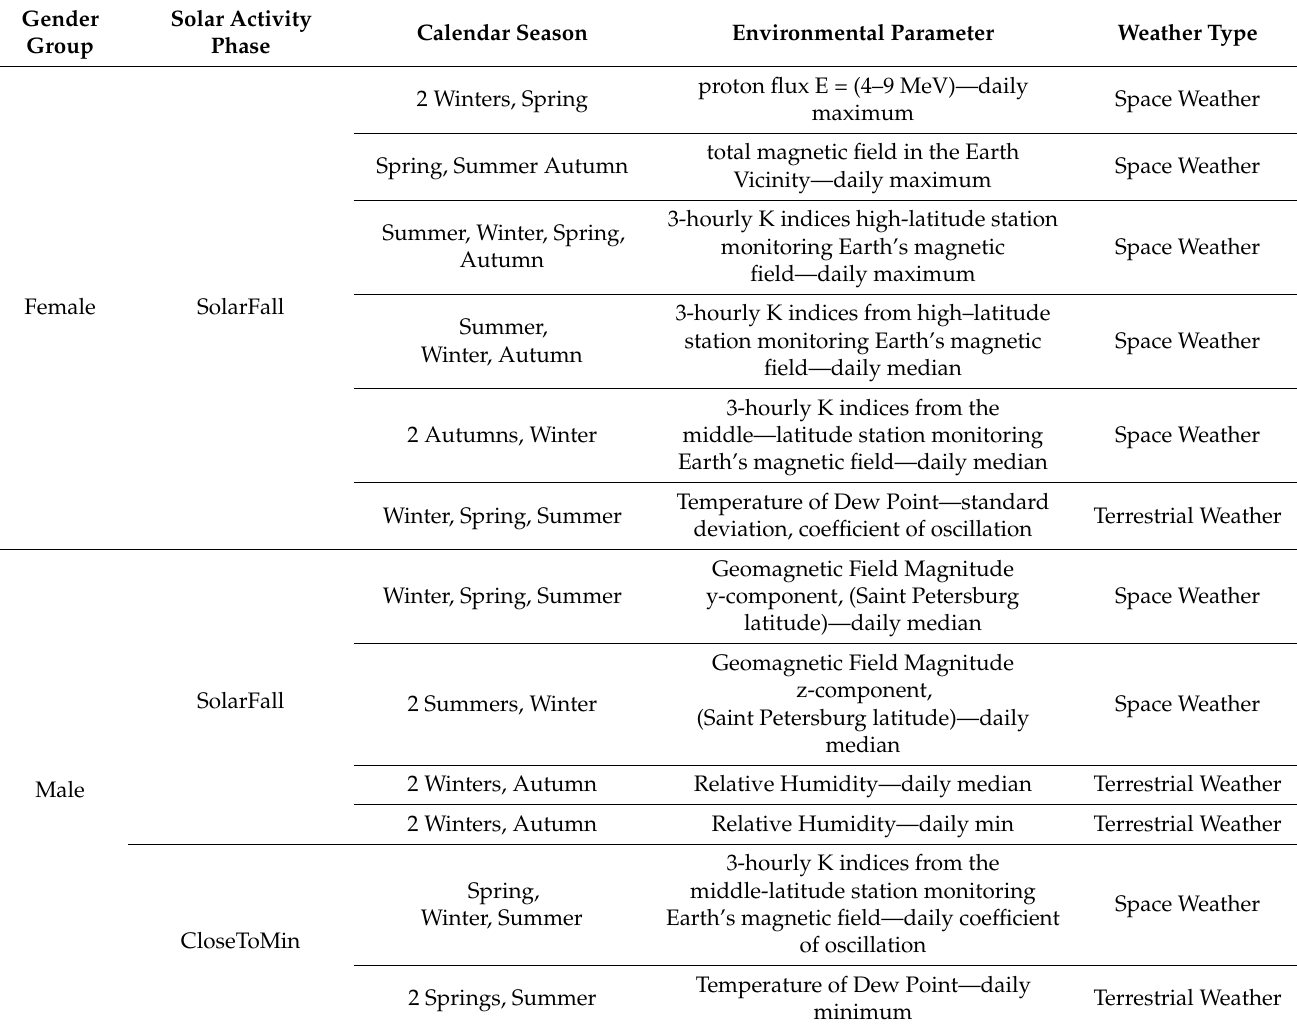
Table 3. The list of the revealed parameters that were different at the moments (the days) of the different medical events, Nobody and Middle, and were specific for each of different gender